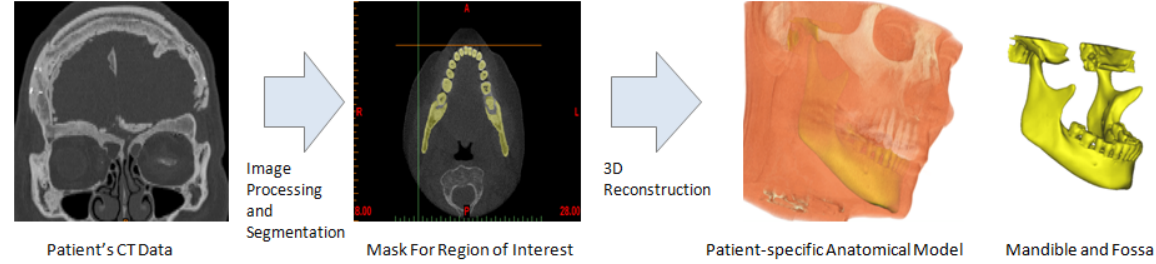
Figure 2. Subject-specific 3D anatomical reconstruction of the patient’s mandible and fossa eminence performed from computed tomography (CT) data using Mimics software.